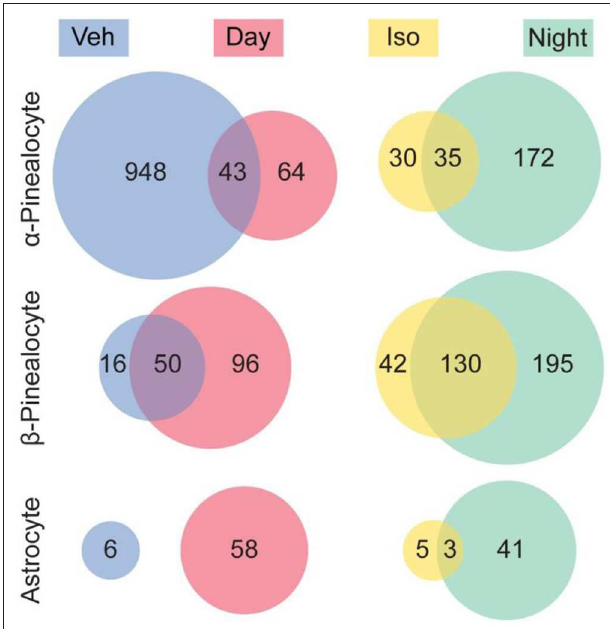
FIGURE 7 | Comparison of differentially expressed genes between the night time pineal gland and isoproterenol-treated pineal gland. Venn diagrams indicate the number of genes that were significantly differentially expressed (DE) in the pineal gland. There was overlap between genes exhibiting DE upregulated at night and by isoproterenol (Iso) treatment, as well as overlap between genes exhibiting DE upregulated during the day and upregulated in the vehicle control treated (i.e., downregulated by isoproterenol treatment), in 3 cell types. Other cell types are not shown. Reproduced from Mays et al. ( 43). This figure and associated legend is published with permission of the original publisher under license